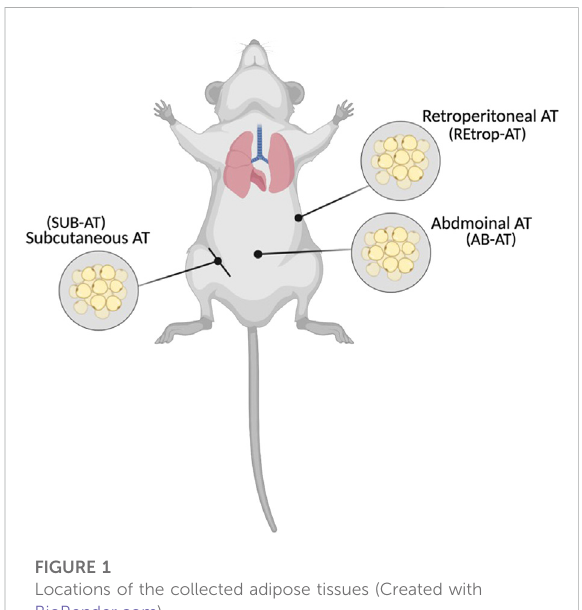
FIGURE 1 Locations of the collected adipose tissues (Created with